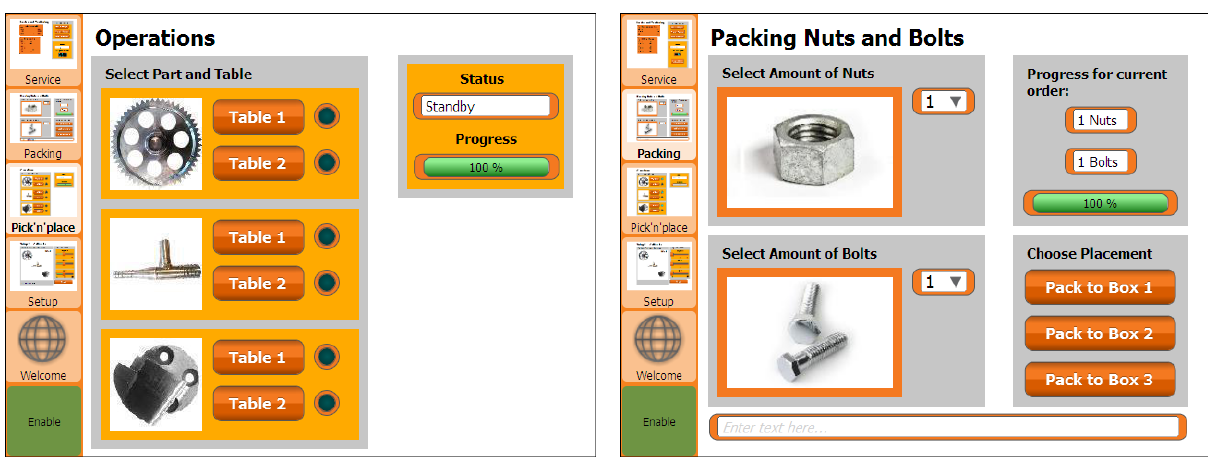
Figure 5: FGUI screen for pick and place service Figure 6: FGUI screen for packaging